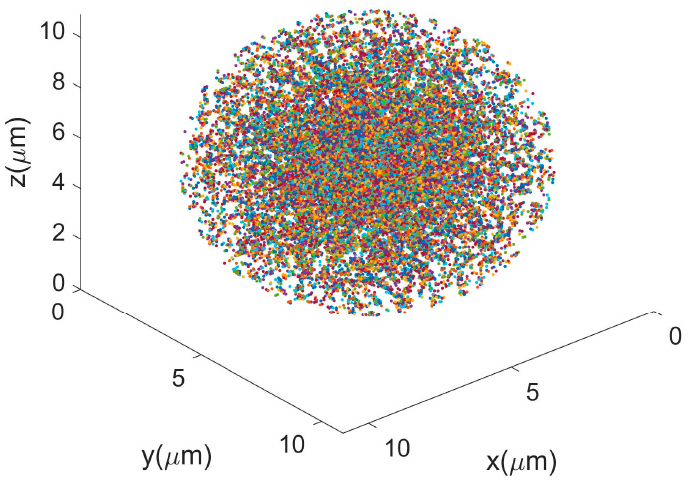
Figure 10. Geometric model of PSH for DDA simulation.